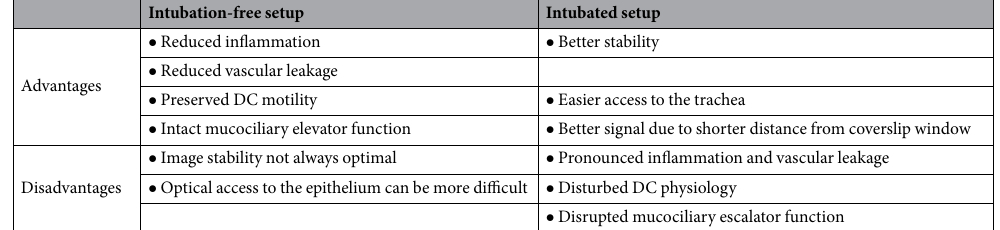
Table 1. Comparison of the new, intubation-free setup with the previously used, intubated